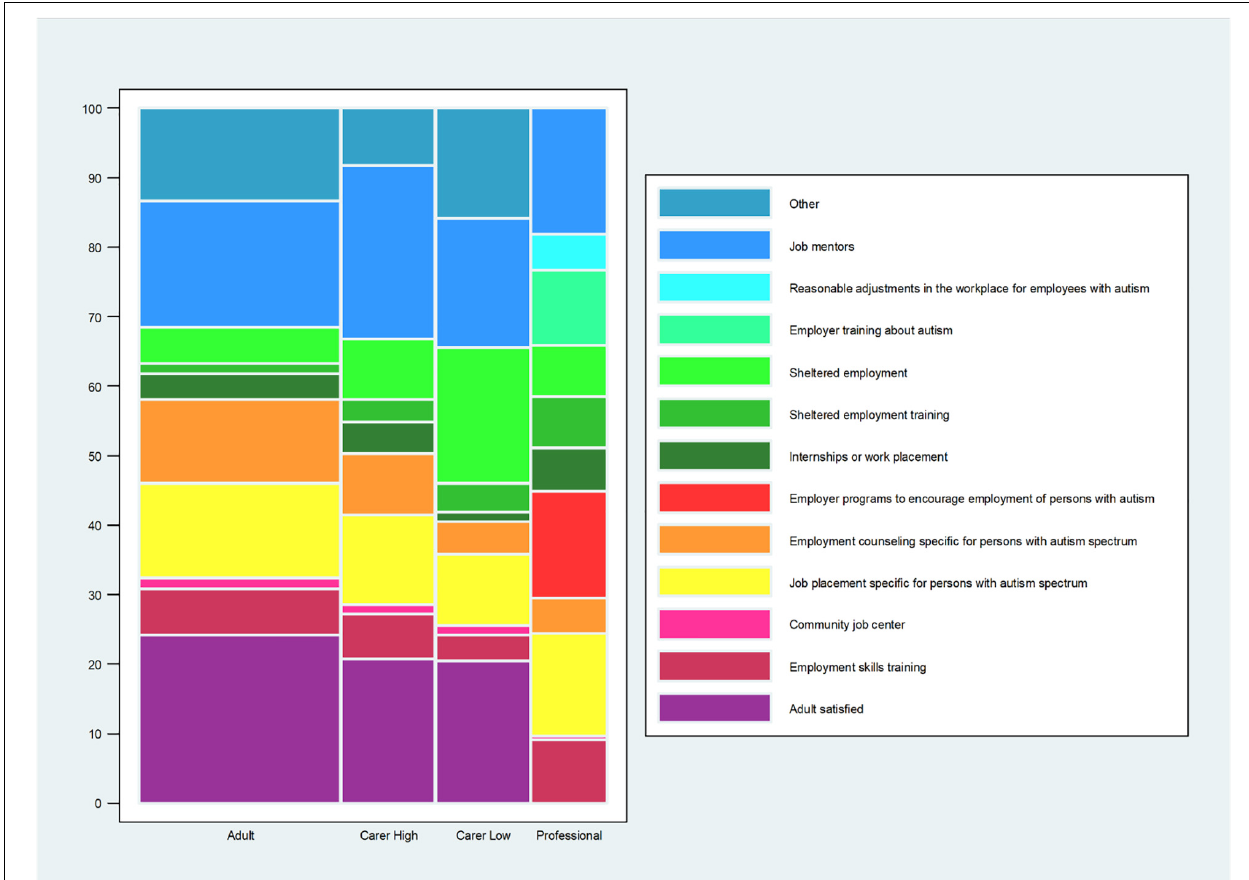
FIGURE 3 | Preferred employment service. The question for the autistic adults was: “ If you could choose an employment service that fits your needs best now, what would you choose? (Please, tick 1 box).” The question for the carers of autistic adults was: “If you could choose an employment service that fits the adult’s needs best now, what would you choose? (Please, tick 1 box).” The carers’ data are stratified by high and low level of independence of the autistic adult. The question for the professional was: “Which 2 types of employment services do you think are most needed for autistic adults in the (geographical) area where you work now? (Please, tick 2 boxes).” Professionals who selected “ I prefer not to make a choice ” are not included in the calculation of% for each of the other answer choices. The%s for the other answer choices are based on the professionals who made a choice, n = 176 (198–22 = 176). *This% is calculated on the total sample of the professionals’ responders ( n = 198). Data are for all adults and carers of